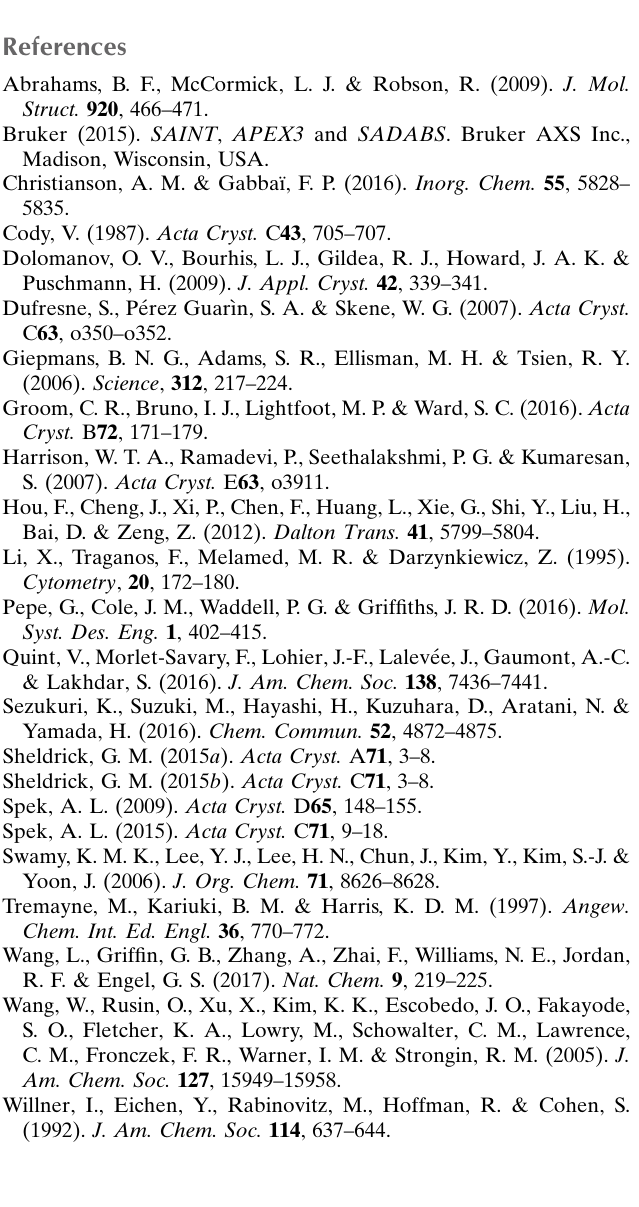
Crystal data Chemical